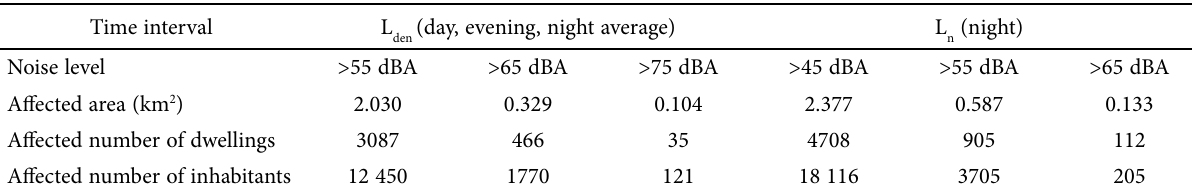
and L time intervals with noise barrier den n